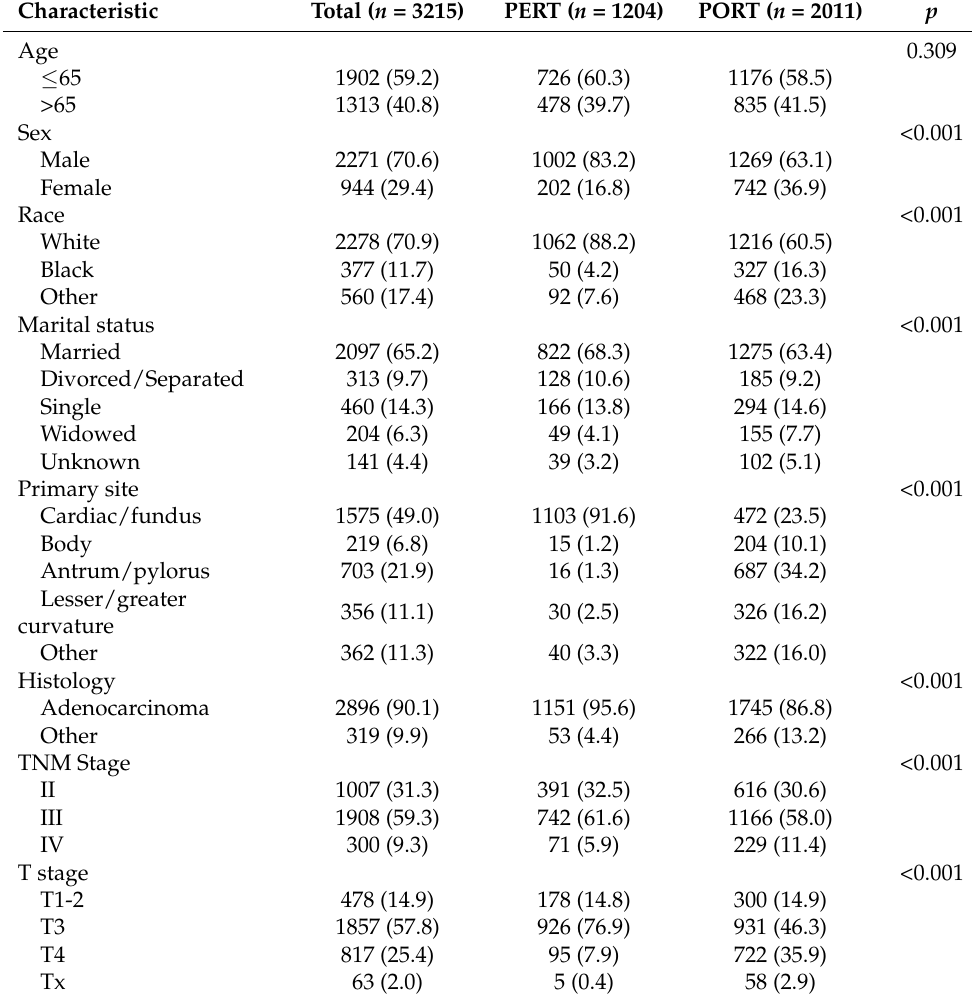
Table 1. Baseline demographic and clinical characteristics of patients with gastric